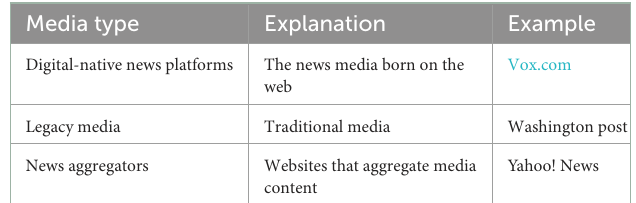
TABLE 3 Definitions of media